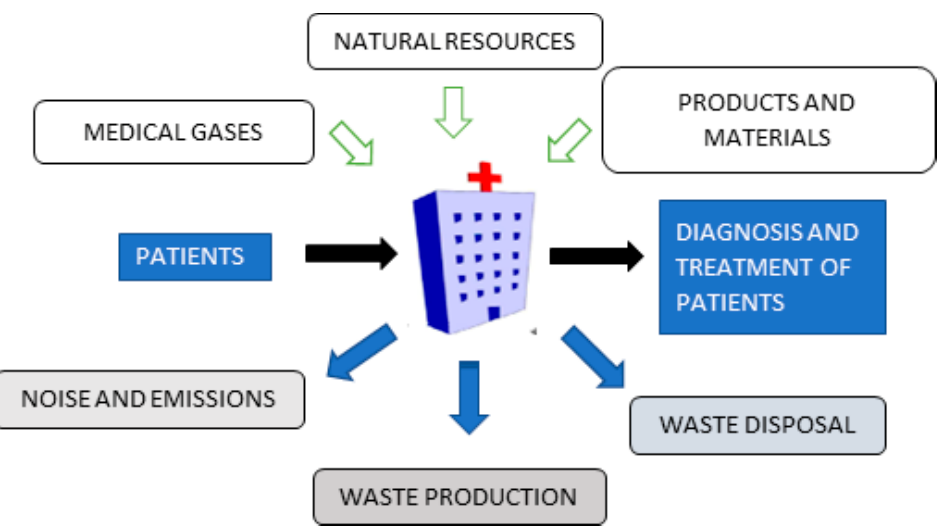
Figure 2. Environmental aspects associated with the activities and services provided by the hospital.